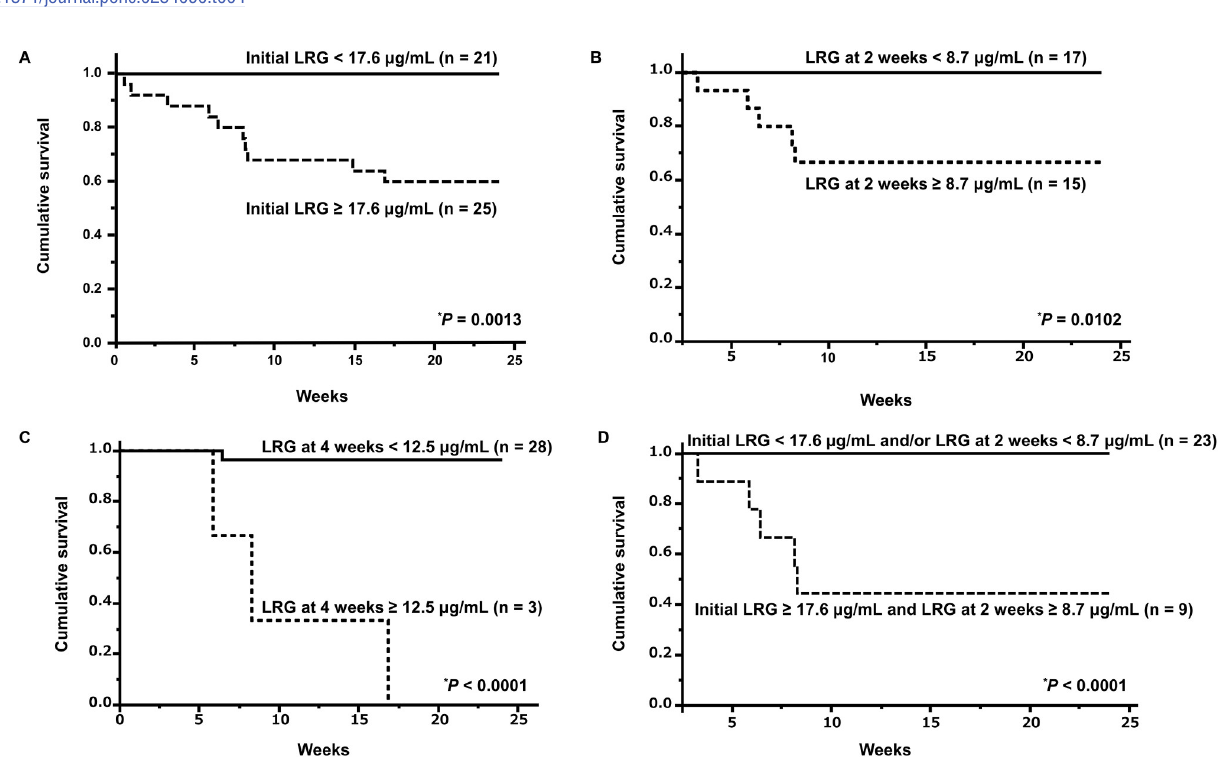
Fig 2. Survival curves of patients with DM-IP based on their serum LRG levels. The survival rate after 24 weeks in patients with an initial LRG level � 17.6 μ g/mL (survival rate: 60%) was significantly lower than that in patients with an initial LRG level < 17.6 μ g/mL (100%) ( P = 0.0013). Solid line: < 17.6 μ g/mL, dashed line: � 17.6 μ g/mL (A). The survival rate after 24 weeks in patients with LRG level at 2 weeks after treatment � 8.7 μ g/mL (67%) was significantly lower than that in patients with LRG level at 2 weeks after treatment < 8.7 μ g/mL (100%) ( P = 0.0149). Solid line: < 8.7 μ g/mL, dashed line: � 8.7 μ g/mL (B). The survival rate after 24 weeks in patients with LRG level at 4 weeks after treatment � 12.5 μ g/mL (0%) was significantly lower than that in patients with LRG level at 4 weeks after treatment < 12.5 μ g/mL (96.8%) ( P = 0.0009). Solid line: < 12.5 μ g/mL, dashed line: � 12.5 μ g/mL (C). The survival rate after 24 weeks in patients with an initial LRG level � 17.6 μ g/mL and that at 2 weeks � 8.7 μ g/mL (survival rate: 44%) was significantly lower than that in patients with an initial LRG level < 17.6 μ g/mL and/or that at 2 weeks < 8.7 μ g/mL (100%) ( P < 0.0001). Solid line: an initial LRG level < 17.6 μ g/mL and/or that at 2 weeks < 8.7 μ g/mL, dashed line: an initial LRG level � 17.6 μ g/mL and that at 2 weeks � 8.7 μ g/mL (D). Survival rates were calculated by the Kaplan-Meier method and compared by a log-rank test. � P < 0.05. DM, dermatomyositis; IP, interstitial pneumonia; LRG, leucine-rich α 2-glycoprotein.